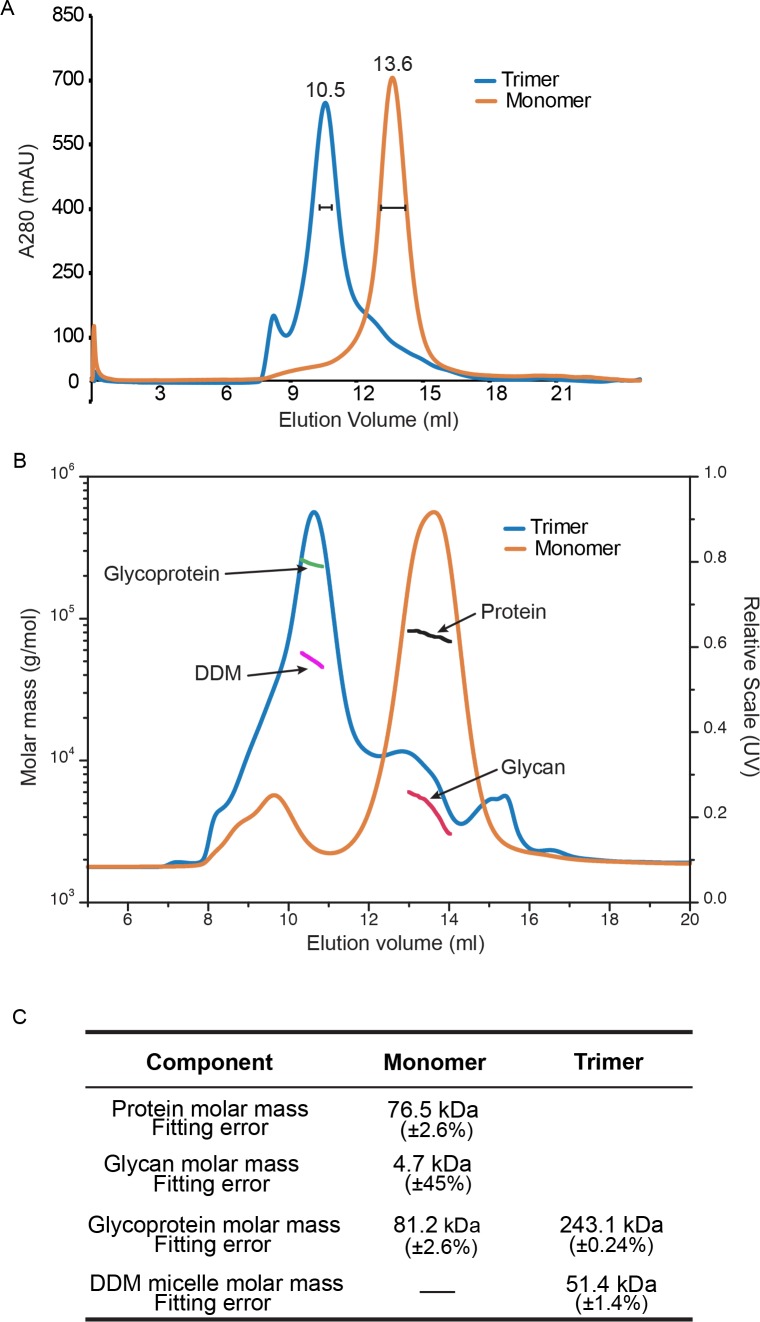
Purification and Trimerization of HAP2.(A) Size exclusion chromatography of HAP2 preparations used in HDX. Monomer and trimer were prepared and subjected to Superdex 200 chromatography as described in Materials and methods. Fractions marked with brackets were used in HDX. (B–C) SEC-MALS (see Materials and methods). (B) UV A280 absorption peaks of trimer and monomer (right axis) are arrowed as are the masses of components from conjugate analysis (left axis). (C) Calculated protein, glycan, glycoprotein, and DDM micelle masses from the protein conjugate model (Materials and methods). Errors are fitting errors.